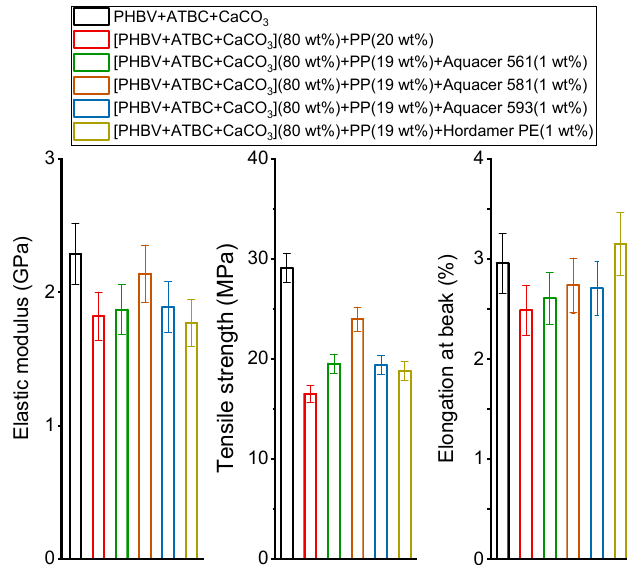
Figure 6. Elastic modulus, tensile strength and elongation at break of the PHBV based biocomposites indicated in the legend (estimated errors from standard deviation for elastic modulus, and elongation at break: ± 10%; for tensile strength ± 5%).